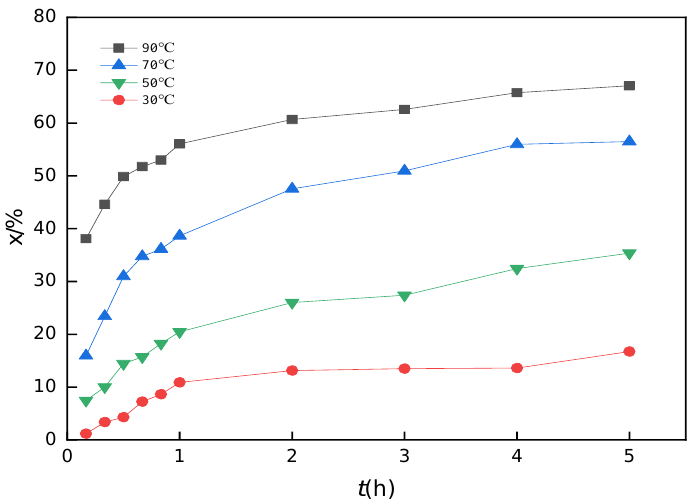
Minerals 2022 , 12 , x FOR PEER REVIEW Figure 12. Effects of temperature on the extraction ratios of aluminum ions. Figure 12. Effects of temperature on the extraction ratios of aluminum ions.